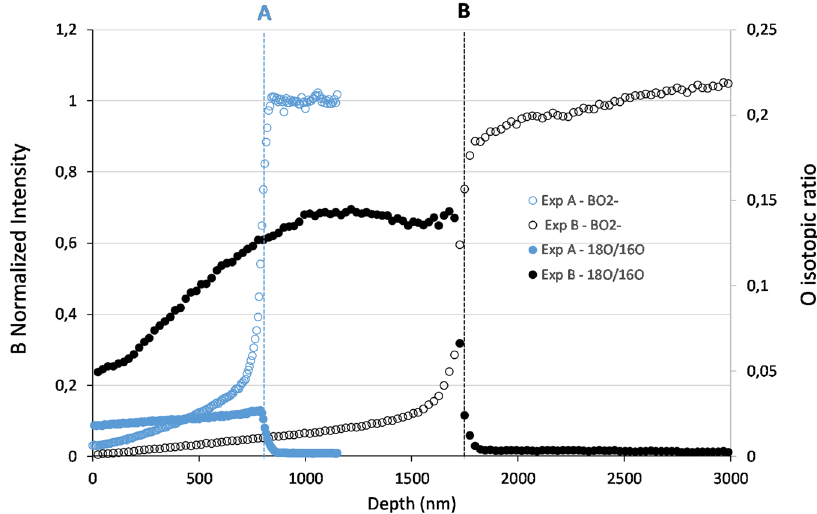
Fig. 12 ToF-SIMS pro fi les for samples A and B after tracing for 24 h in a solution enriched in H 218 O. The alteration fronts are shown by the vertical dotted lines. The isotopic ratios 18 O/ 16 O are quantitative, and given on the axis on the right. The alteration layer formed on the irradiated glass incorporated ~3 times more H 2 18 O than the non-irradiated